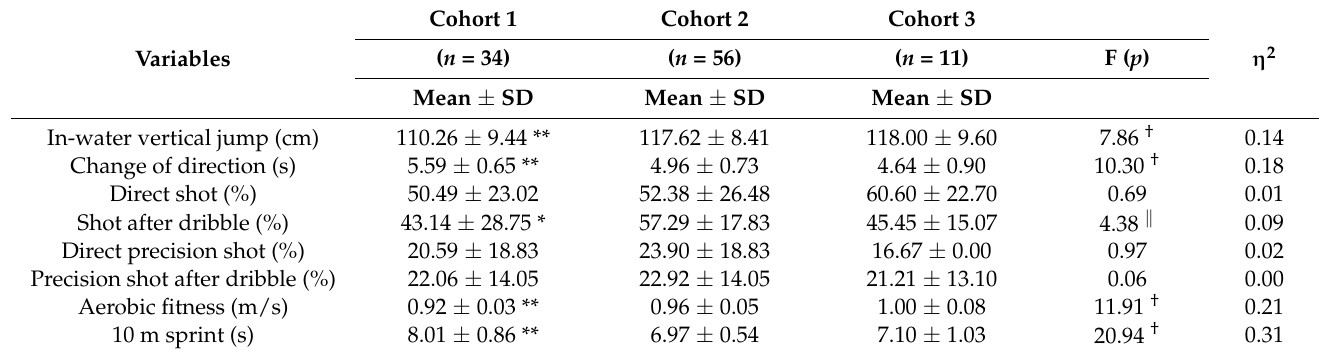
Table 3. Mean ± SD values of age-group-specific motor